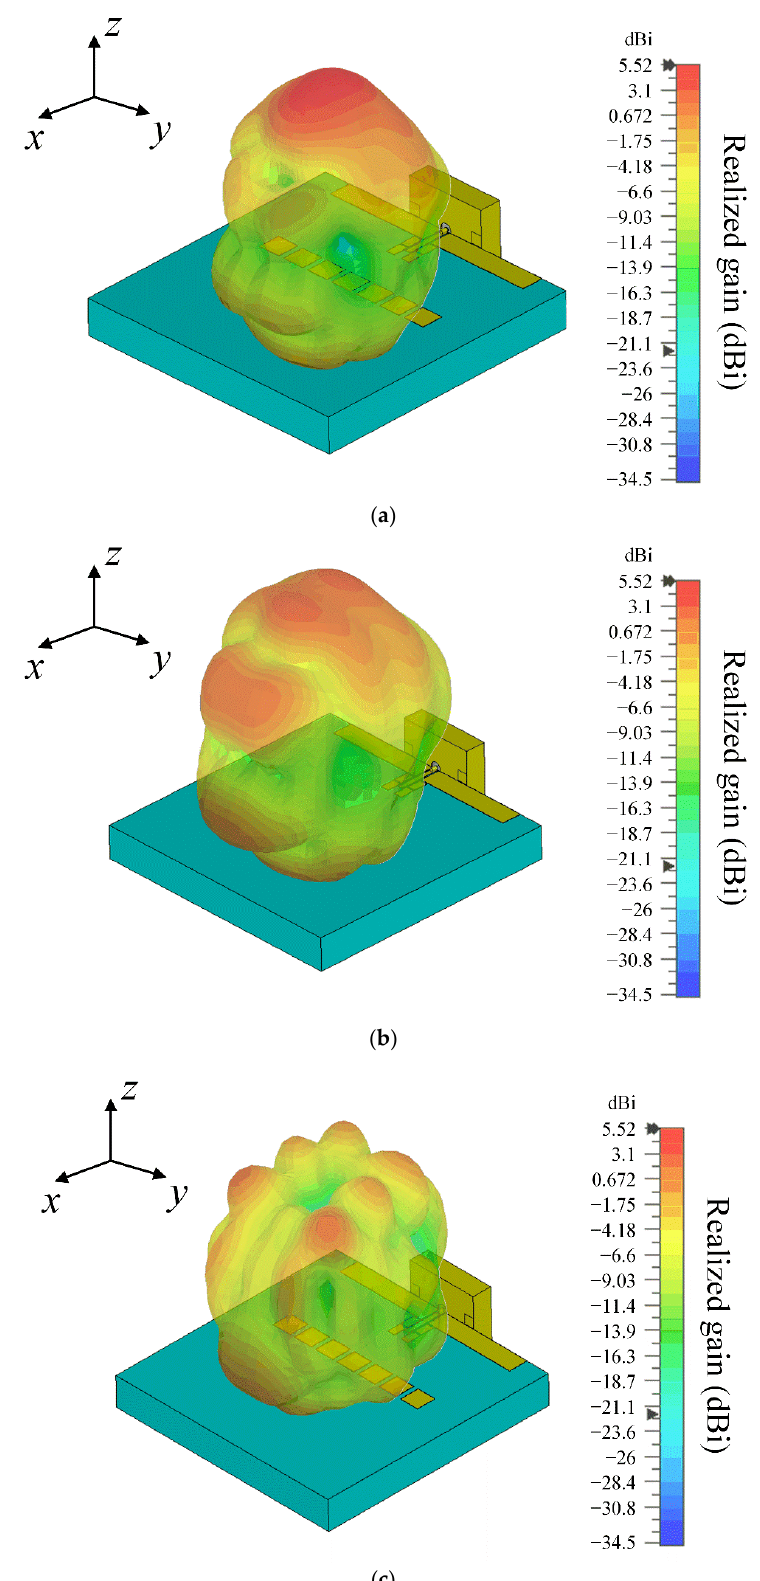
Figure 16. 3-D radiation patterns by simulation: ( a ) proposed antenna; ( b ) without the director; ( c ) without the reflector.